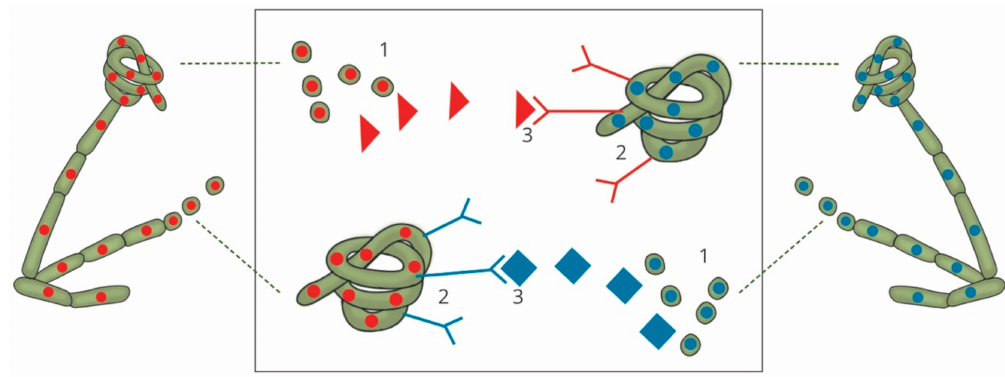
Figure 5. Pheromone signalling in heterothallic filamentous ascomycetes. (1) Pheromones are expressed, with spermatia of MAT1-1 isolates expressing the α -factor and spermatia of MAT1-2 isolates expressing the a -factor pheromone. (2) The ascogonia of these isolates also express the pheromone receptors, which recognize the pheromones. (3) Recognition of the pheromones by their receptors results in a variety of physiological changes, including growth towards the suitable partner as well as the transcriptional regulation of sex-related